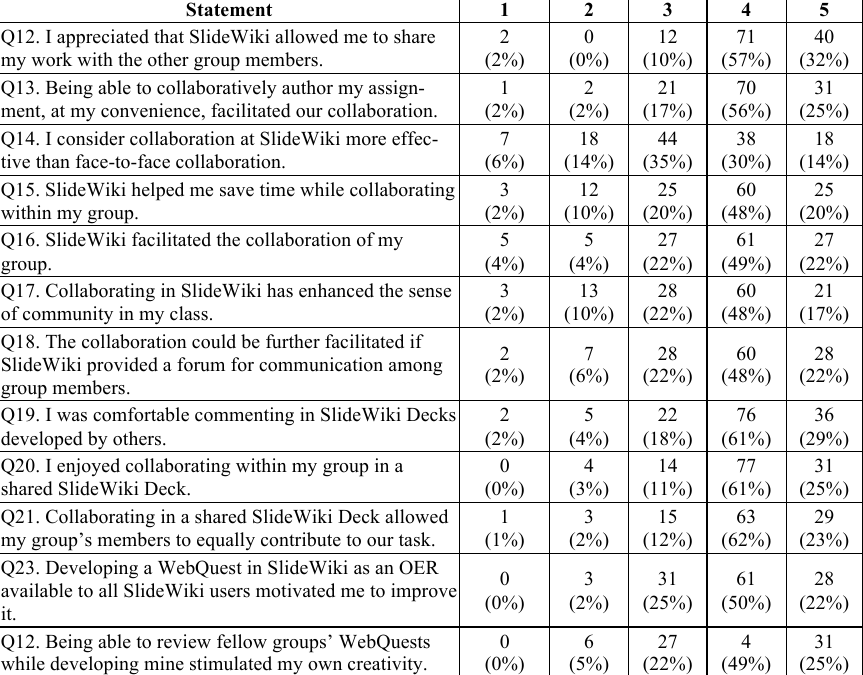
Table 4. Distribution of the students’ responses in statements Q12 to Q23 of Section B